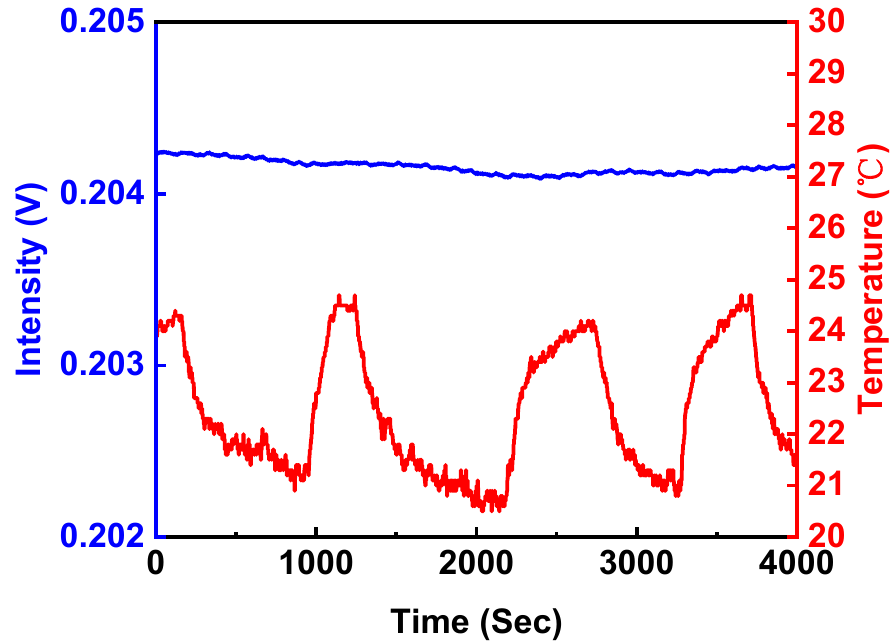
Figure 5. The temporal stability and effect of temperature fluctuation with the new generation of FOPPR sensor with proper heat-insulation.